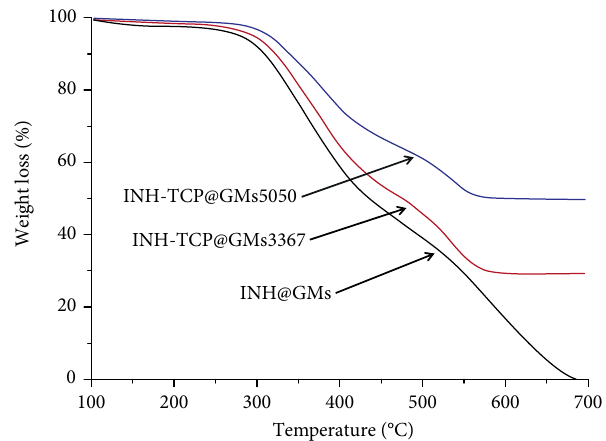
Figure 2: TGA curves of various INH-loaded microparticles.